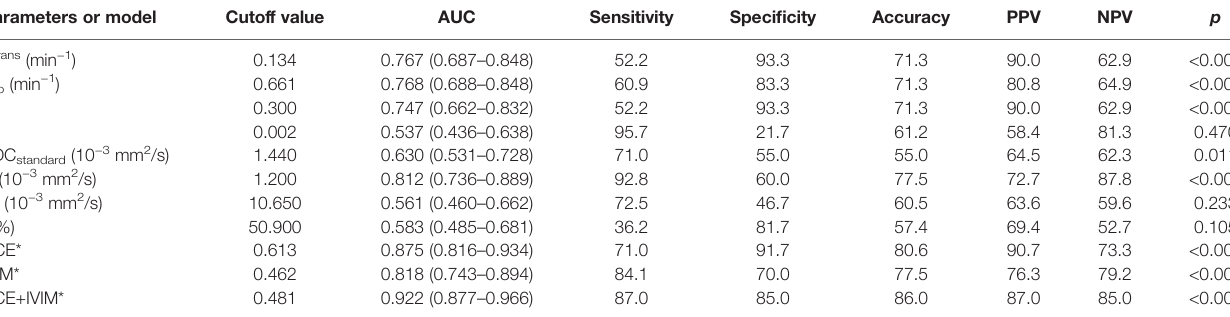
TABLE 4 | Diagnostic performance of DCE-MRI and IVIM-DWI quantitative parameters and their combinations in discriminating treatment response to NCT in LAGC patients. Parameters or